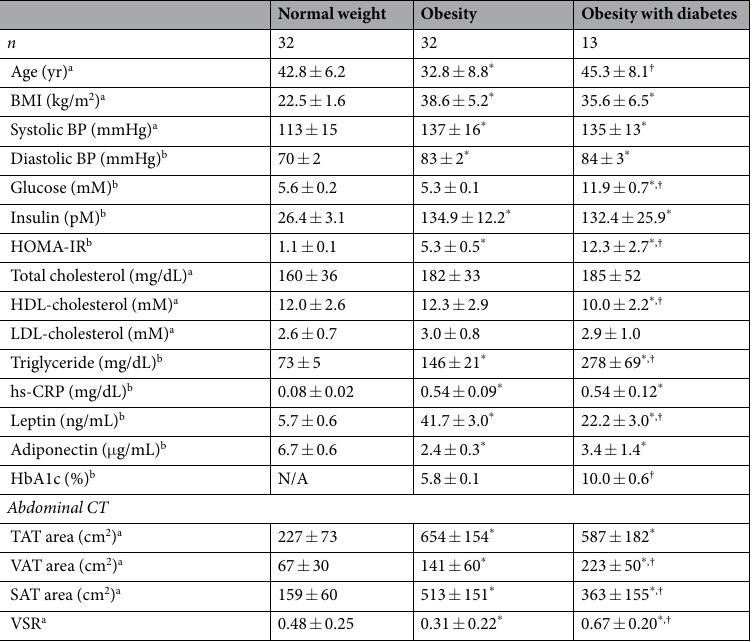
Table 1. Metabolic parameters and abdominal fat distribution of the non-diabetic obese, obese type 2 diabetic, and normal weight control groups. a Data are shown as the mean ± SD. b The data were log-transformed for statistical analysis. Data are shown as the mean ± SE on the original (back-transformed) scale. * p < 0.05 vs . control, † p < 0.05 vs . obesity group analyzed using one-way ANOVA followed by Tukey’s post hoc test. N/A, not